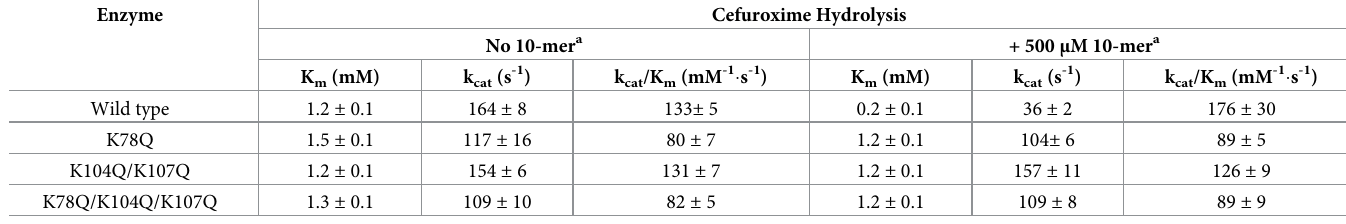
Table 2. Steady-state parameters of 5/B/6 MBL mutants. Enzyme